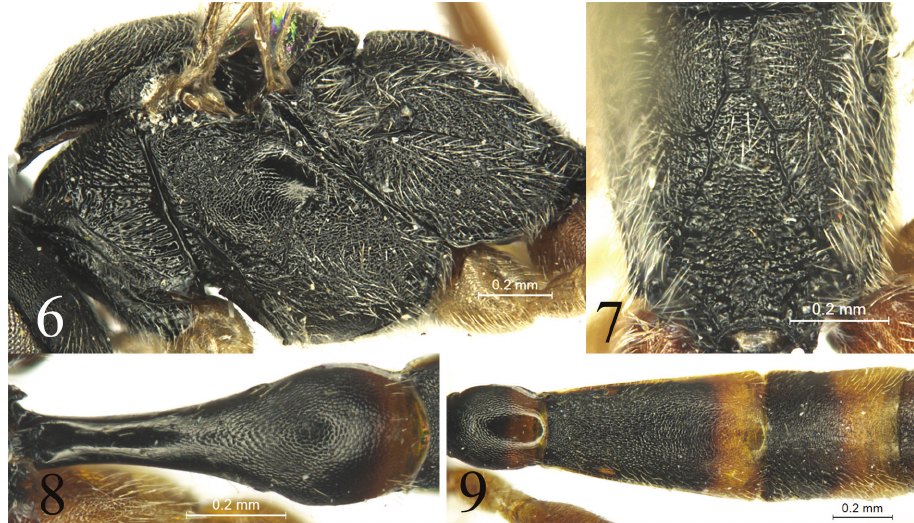
Figures 6–9. Cymodusa culaiica Sheng, Li & Sun, sp. nov. Holotype. Female 6 mesosoma, lateral view 7 propodeum, dorsal view 8 first tergite, dorsal view 9 postpetiole and tergites 2 and 3, dorsal